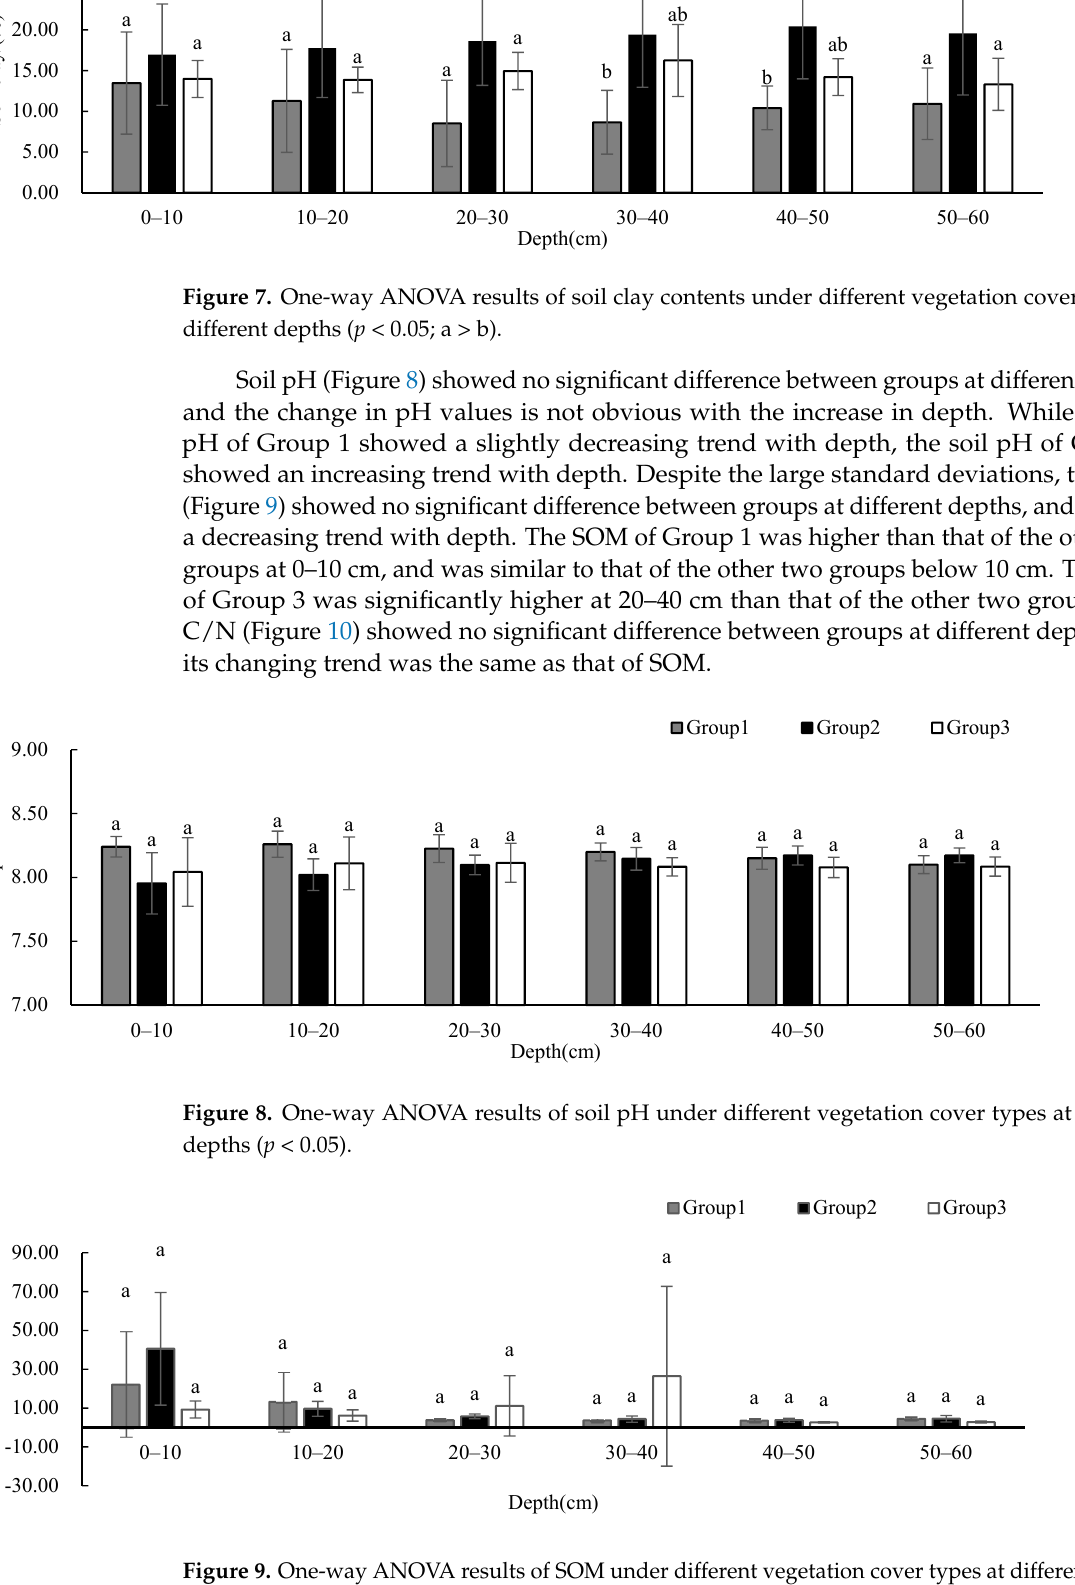
Figure 9. One-way ANOVA results of SOM under different vegetation cover types at different depths ( p < 0.05).